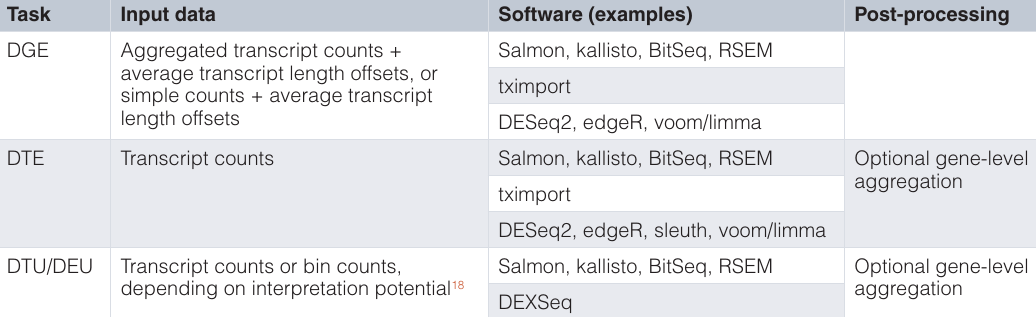
Table 2. Summary of suitable analysis approaches for the three types of comparative analyses discussed in the manuscript (DGE, DTE and DTU).